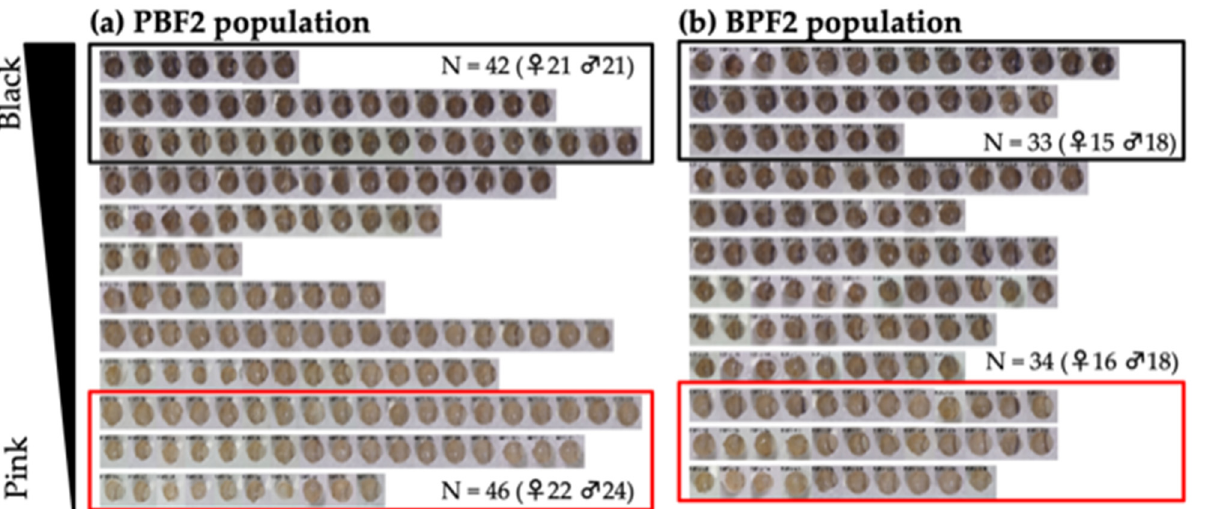
Figure 1. Age-related changes in eye color of ordinary pink-eyed (PINK) and novel black-eyed (BLACK) mutant strains on the C57BL/6JJcl background: ( a ) External appearances of a PINK mouse at the F36 generation and a BLACK mouse at the F31 generation. The same mouse in each strain was photographed from 1 to 3 months of age; ( b ) stereomicrographs of eyeballs from PINK mice at F32–33 generations and BLACK mice at F26–29 generations.